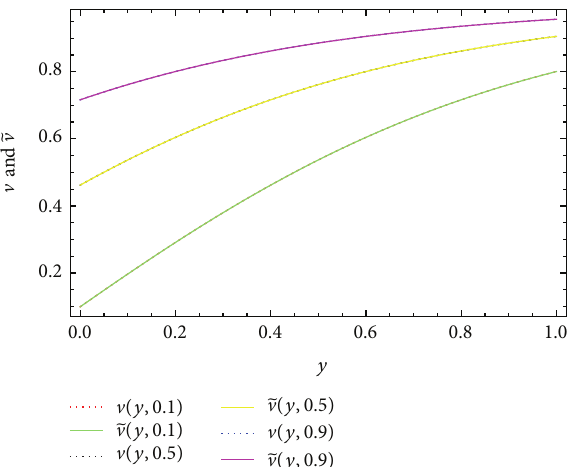
Figure 11: The approximate ̃ V and the exact V solutions for different values of 𝑡 = 0.1 , 0.5, and 0.9 of problem (51), where 𝑁 = 12 and 𝛼 = 𝛽 = −(1/2) in the interval [0, 1] .